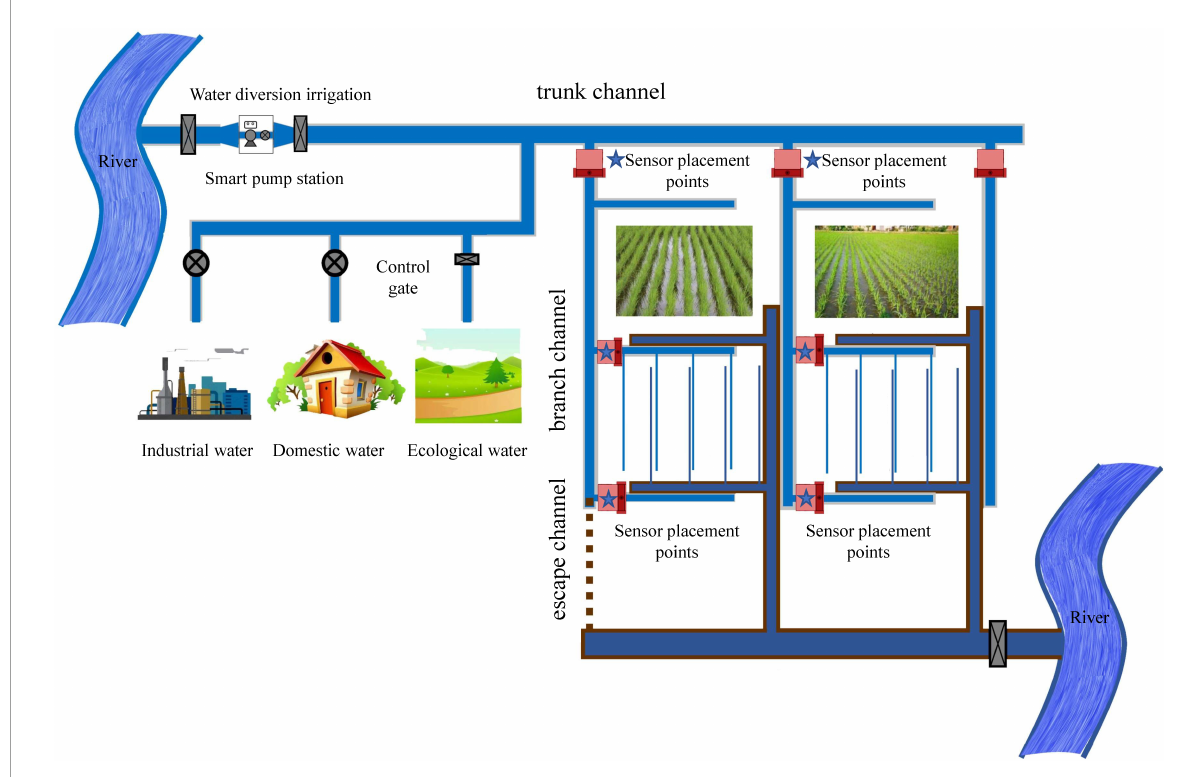
FIGURE1 The whole process of water transmission and distribution in the irrigation area and the layout of flow measurement